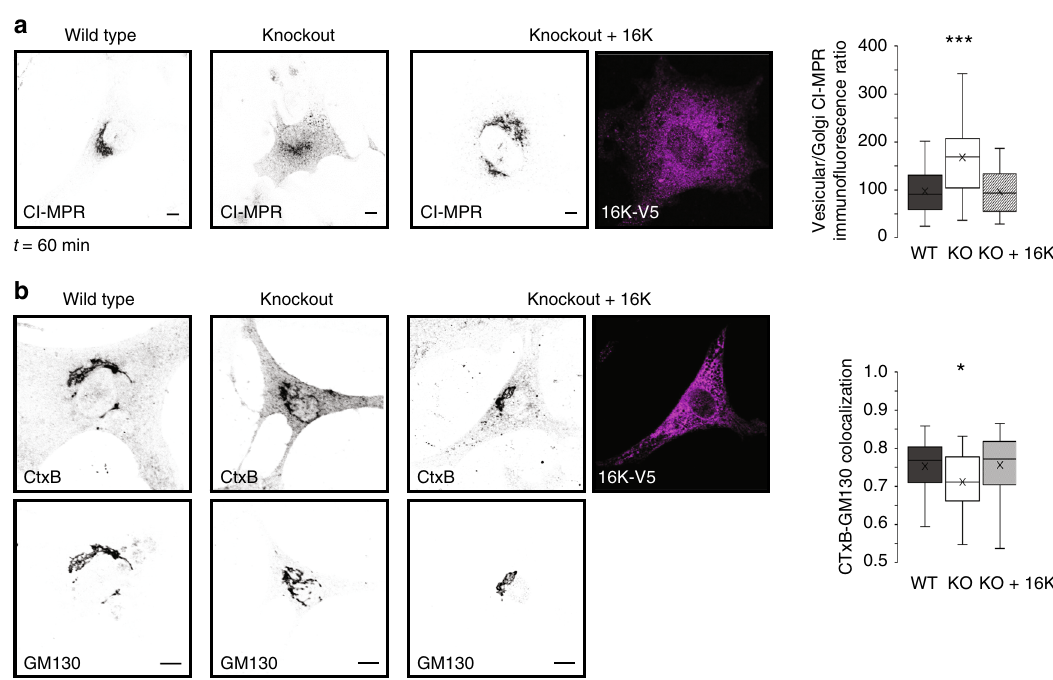
Fig. 3 TMEM16K requirement for endosomal retrograde transport. a Left, Immuno fl uorescence of pulse chased antibody detecting CI-MPR internalized from the plasma membrane at 60 min time point in the WT, TMEM16K KO cell and TMEM16K KO cell with reintroduced TMEM16K. Scale bar 10 μ m. Right, Ratio of measured intensity between vesicular region of the cell and the region encompassing Golgi (10 × 10 µ m 2 ). Single factor ANOVA, p value = 4.65E − 37, post-test Bonferroni-corrected two sided t- test with pairwise comparison with WT (three biological replicates, n = 168 WT, 181 TMEM16K KO, p value = 1.37E − 26***, and 134 KO + 16K cells). b Left, Immuno fl uorescence of Golgi marker GM130 and internalized conjugated cholera toxin B (CtxB) from the plasma membrane at 60 min time point in the WT, TMEM16K KO cell and TMEM16K KO cell with reintroduced TMEM16K. Scale bar 10 μ m. b Right, Quanti fi cation of the Pearson ’ s correlation coef fi cient measuring colocalization of GM130 and CTxB. Single factor ANOVA, p value = 0.0018 with post-test Bonferroni-corrected two sided t -test with pairwise comparison with WT (three biological replicates, n = 40 WT, 57 TMEM16K KO, p value = 0.0051*, and 56 KO + 16K cells). In the box and whiskers plot, the box includes the fi rst quartile and the third quartile, with the central line representing the median. Whiskers represent the minimum and maximum values of data. X inside the box represents the mean of data. Source data are provided as a Source Data fi